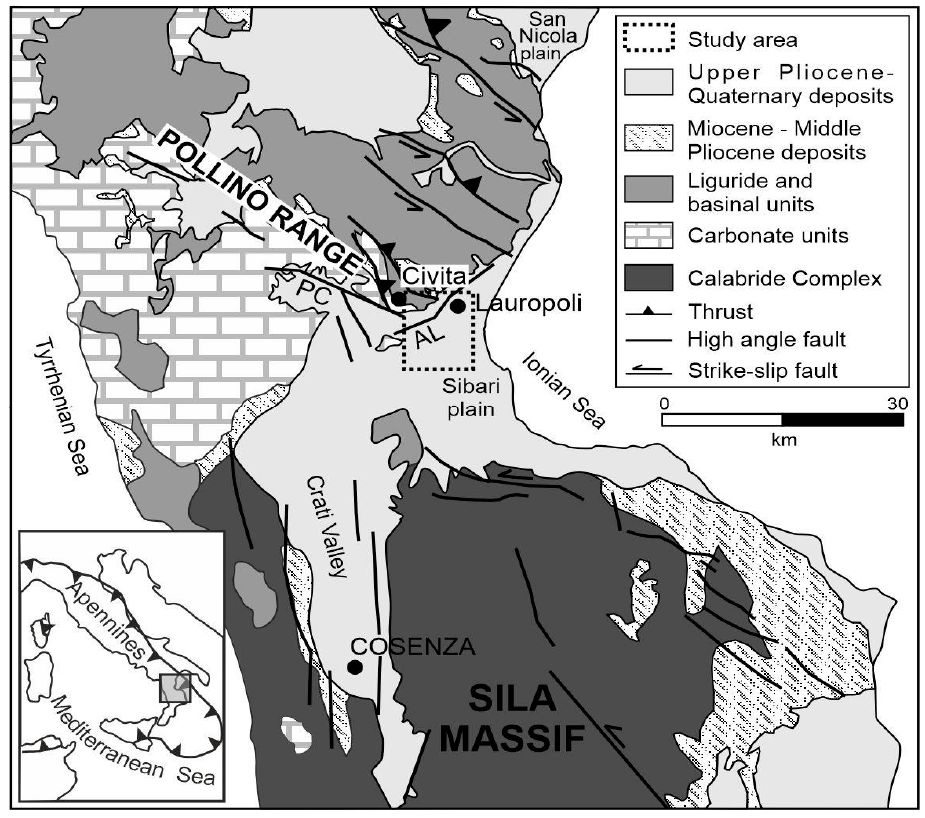
Figure 1. Geological sketch-map of southern Apennines and northern Calabria (modified after